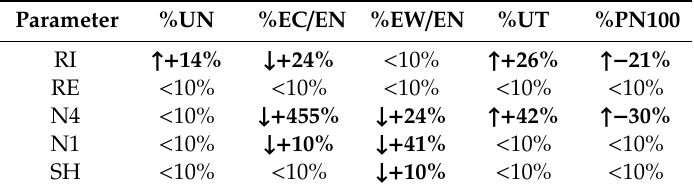
Table 8. Average changes of UN, EC / EN, EW / EN, UT, PN100 due to changes of RI, RE, N4, N1, SH.